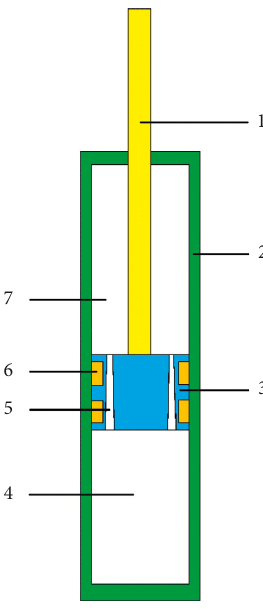
Figure 26: Schematic of the MR damper with tapered MR valve: 1, rod; 2, cylinder; 3, piston; 4, compression chamber; 5, tapered MR valve; 6, coils; 7, rebound chamber